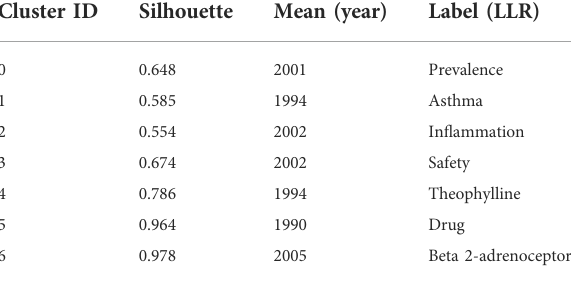
TABLE 2 Co-occurrence map of asthma drug-related study keyword cluster